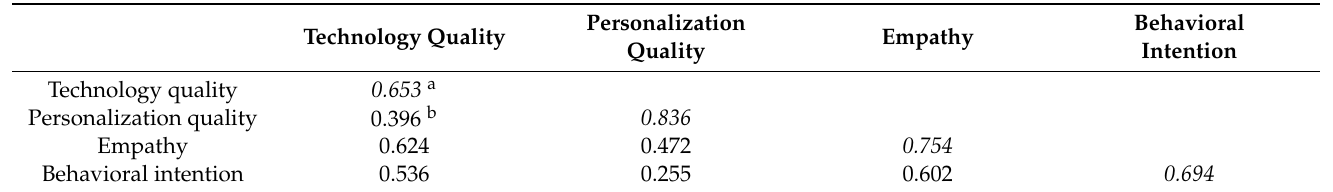
Table 2. AVE, squared correlation